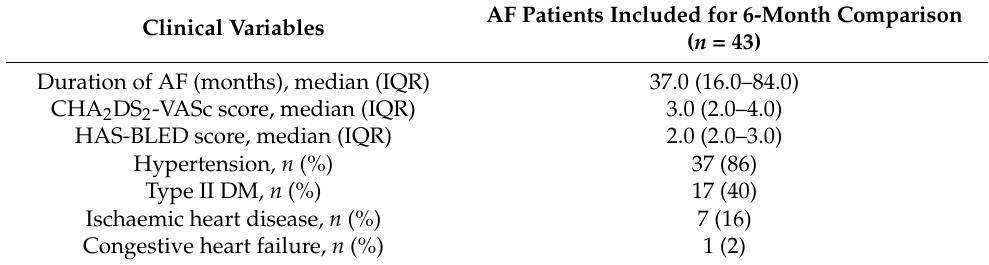
Table 3. Participant clinical characteristics.